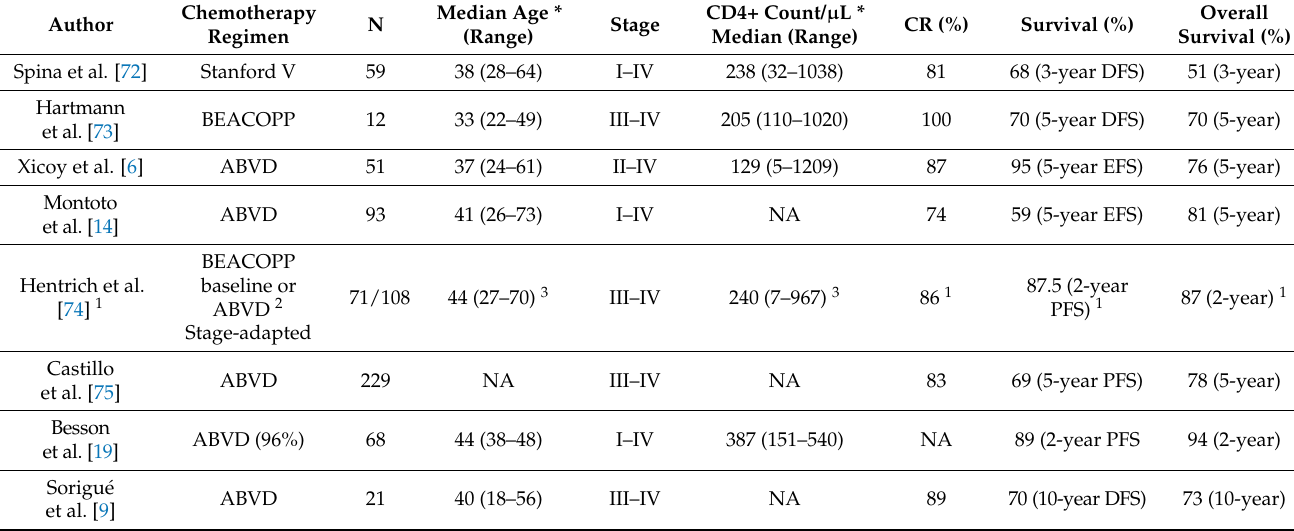
Table 1. Results of front-line treatment of the main studies performed on cHL in PLWH since the introduction of